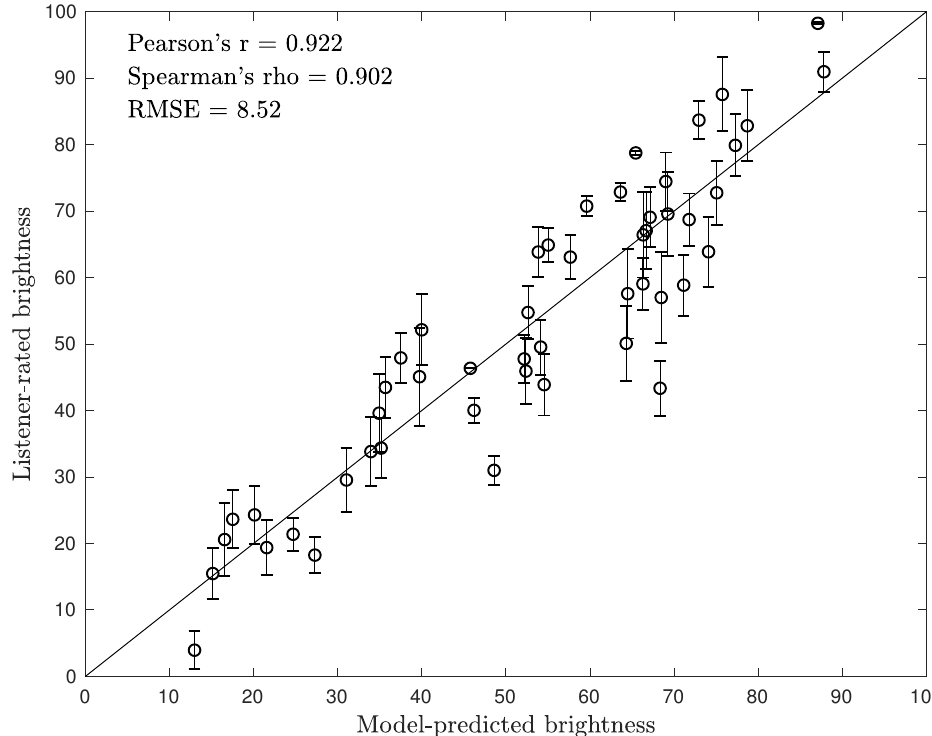
Figure 4. Listeners’ brightness ratings against the best-performing model, across all